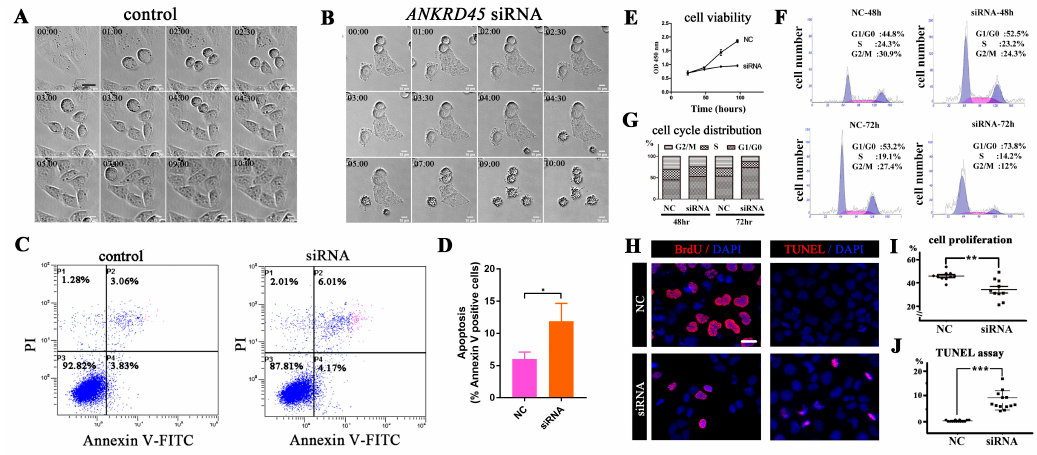
Figure 4. Knockdown of ANKRD45 results in cell cycle defects . ( A , B ) DIC (Di ff erential Interference Contrast) still images obtained from time-lapse microscopy showing HeLa cells undergoing cell division. Compared with control siRNA-treated cells ( A ), knockdown of ANKRD45 ( B ) resulted in the delay of cell division and cell death. ( C , D ) Flow cytometry analysis of Annexin V-FITC and propidium iodide staining of the control and ANKRD45 siRNA-treated Hep3B cells. The percentage of apoptotic cells increased significantly after siRNA treatment ( D ). ( E ) Cell proliferation of Hep3B cells analyzed by CCK-8 assay. ( F , G ) Flow cytometry cell cycle analysis of Hep3B cells treated with control or siRNA. The percentage of cells in di ff erent phases of the cell cycle are shown in (G). ( H ) Confocal images showing proliferating and apoptotic Hep3B cells visualized by BrdU incorporation and the TUNEL assay. ( I ) Quantitative results of the percentage of BrdU positive cells in control or siRNA-treated Hep3B cells. ( J ) Quantitative results of the percentage of apoptotic cells from the TUNEL assay. NC, negative control. Scale bars: 25 µ m. * p < 0.05, ** p < 0.01, *** p < 0.001.